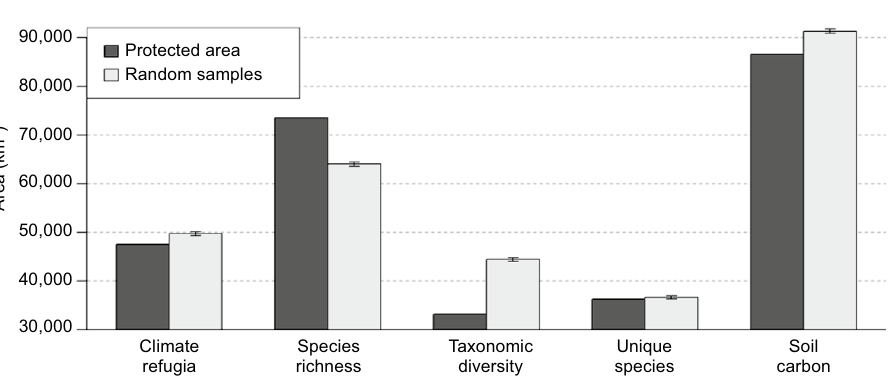
Figure 4. Gap analysis to quantify whether the area of the hotspots within the protected and conserved areas network (dark grey) is consistent with the area expected based on availability across the boreal caribou distribution (light grey) ± 95% confidence intervals. Availability determined from random sampling without